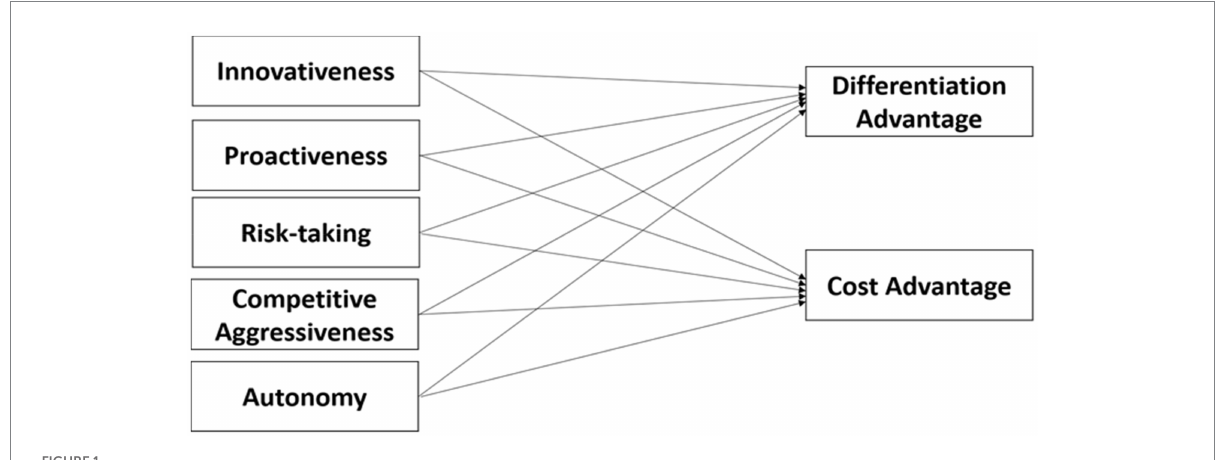
FIGURE 1 Conceptual framework.